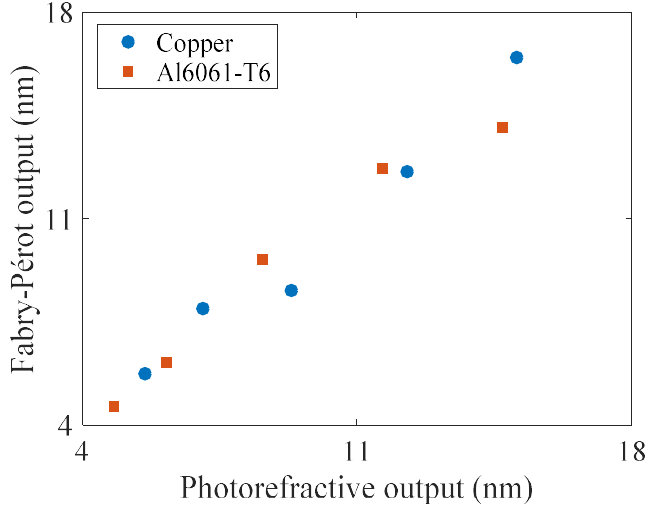
Figure 5. Performance comparison for absolute displacement measurement between photorefractive and Fabry–Pérot interferometers.